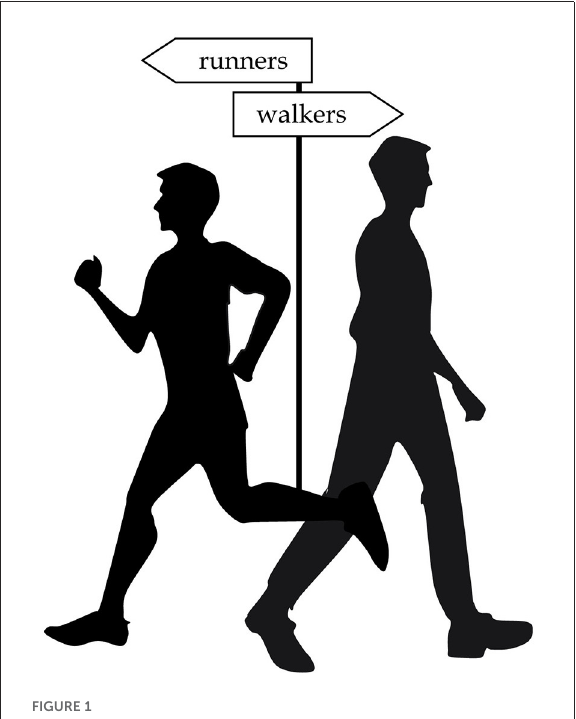
FIGURE1 Are we runners or walkers by